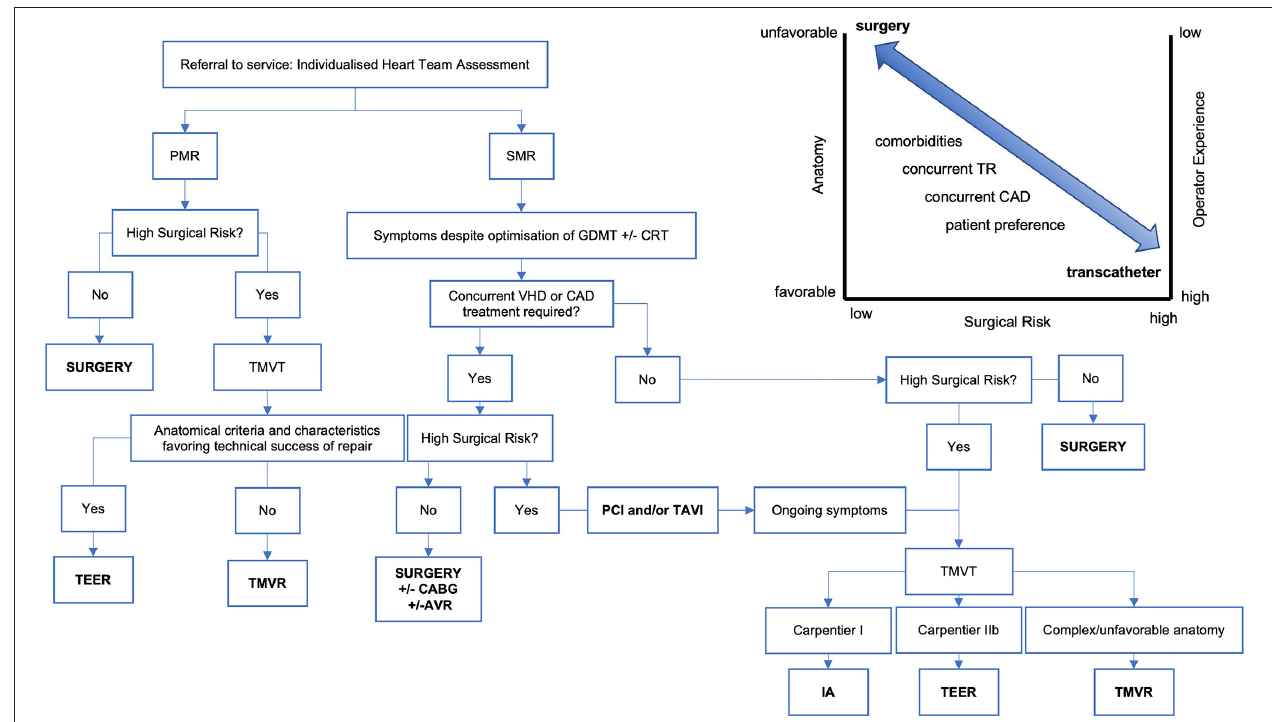
FIGURE 4 | A simplified flowchart demonstrating the processes underpinning the patient journey to therapy for mitral regurgitation. The inset graphic illustrates surgical and transcatheter treatment lying on a continuum and how this decision is influenced by surgical risk, anatomic suitability, and operator experience with additional consideration given to concurrent cardiovascular conditions and patient preference. TMVT, transcatheter mitral valve therapy; PMR, primary mitral regurgitation; SMR, secondary mitral regurgitation; VHD, valvular heart disease; TAVR, transcatheter aortic valve replacement; GDMT, guideline-directed medical therapy; CRT, cardiac resynchronisation therapy; TEER, transcatheter edge-edge repair; TMVR, transcatheter mitral valve replacement; IA, indirect annuloplasty; CABG, coronary artery bypass grafting; PCI, percutaneous coronary intervention; AVR, aortic valve replacement.